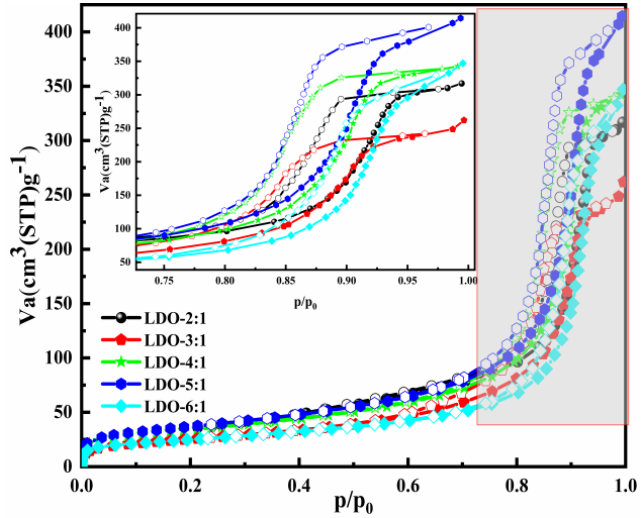
Table 1. Layer spacing of the crystal plane under different ratios of materials.